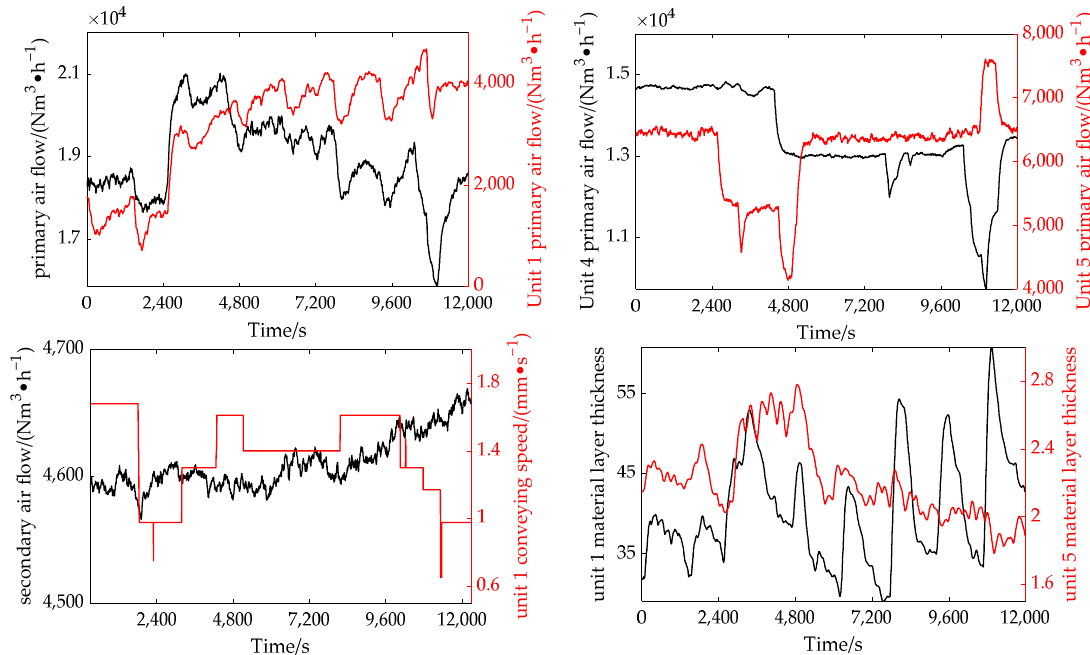
Figure 5. The local trend diagrams of the input variables.